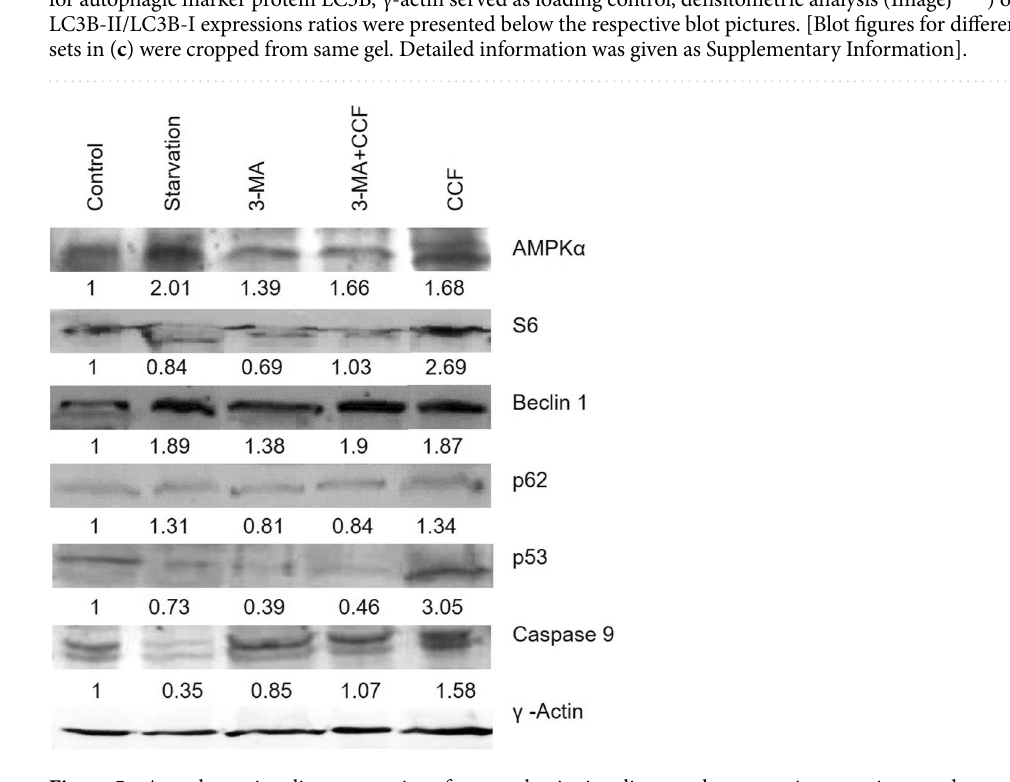
Figure 5. Autaphagy signaling, expressions for autophagic signaling regulator proteins, γ-actin served as loading control. Densitometric (ImageJ 1.52A ) fold changes of expressions of the proteins were presented below the blot pictures. [Blot figures for different sets in were cropped from same gel. Detailed information was given as Supplementary